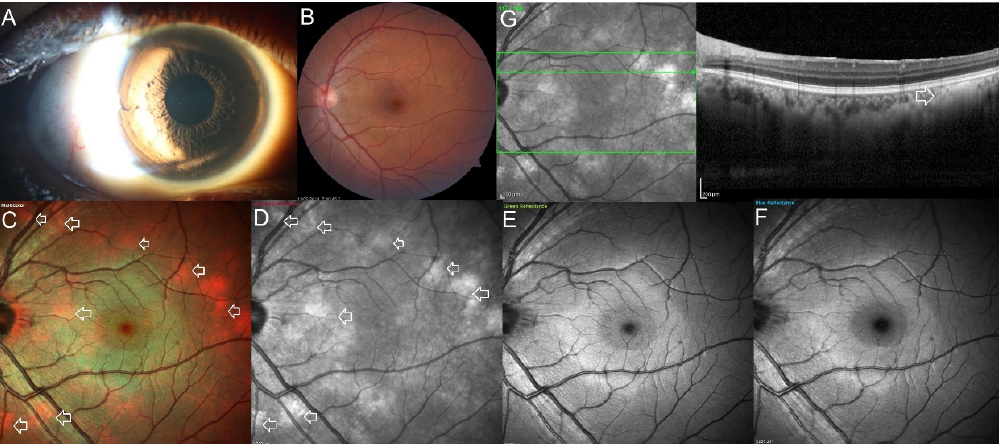
Figure 2. Multimodal imaging in a patient with neurofibromatosis type 2 showing multiple isolated choroidal melanocytic hamartomas in the left eye. ( A ) Slit-lamp photograph with oblique illumination shows the Lisch nodules on the iris surface. ( B ) The 50° conventional color fundus photograph of the left eye looks normal and does not identify any pathological lesions. ( C – F ) The 30° multicolor image shows multiple choroidal melanocytic hamartomas spread across the posterior pole as bright orange-colored lesions (white arrows). On the high wavelength infrared reflectance channel, the lesions appear as white hyperreflective lesions (white arrows). The lesions are not visible on the short wavelength green and blue reflectance channels. ( G ) Enhanced depth imaging optical coherence tomography scan passing through one of the lesions shows increased reflectivity in the choroid with poor visibility of underlying structure at the area of the lesion (white arrow).